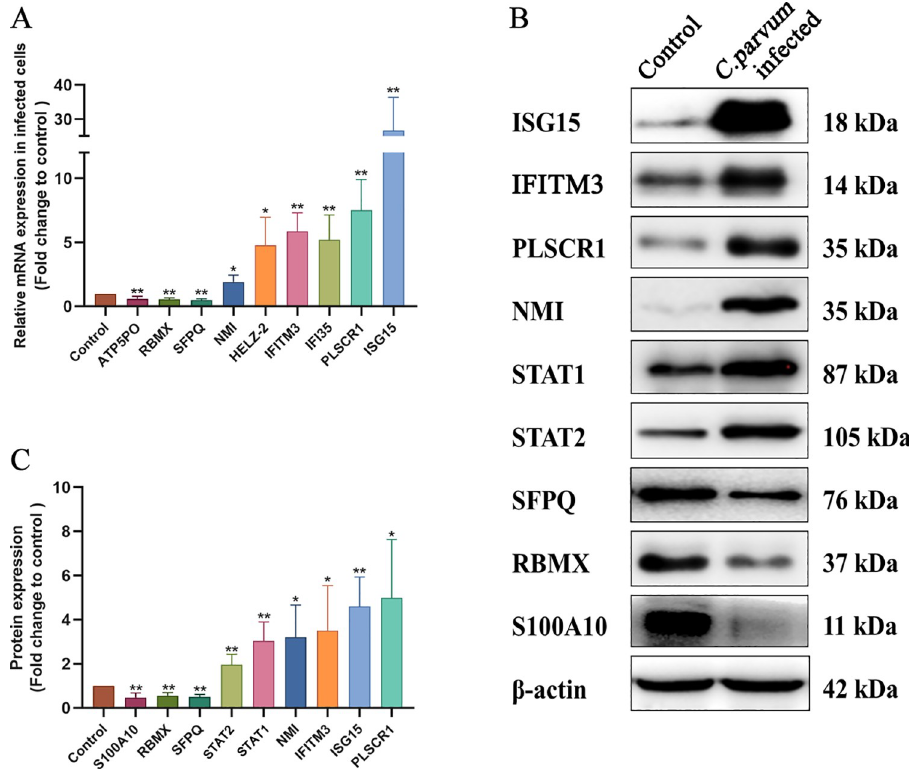
Fig 5. Verification of the DEPs in normal and C . parvum -infected host cells. Each experiment was repeated three times. (A) Relative mRNA expression levels of ATP5PO , RBMX , SFPQ , NMI , HELZ2 , IFITM3 , IFI35 , PLSCR1 , and